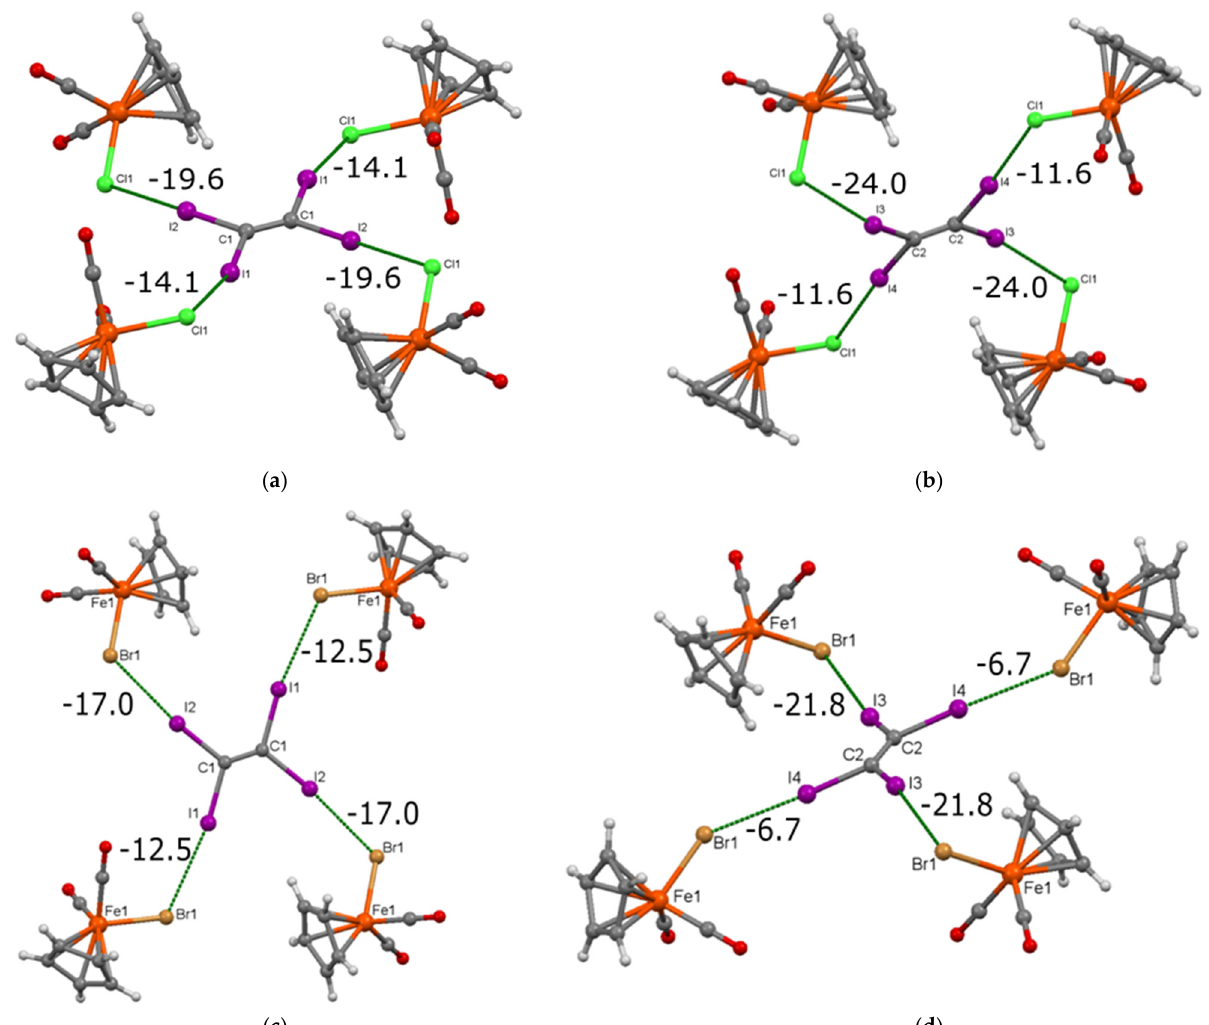
Figure 2. Fragments of the crystal structure of 1 , showing the supramolecular arrangement and intermolecular interaction energies around two independent C 2 I 4 molecules in 1 ( a , b ) and in 2 ( c , d ). Energy values are indicated in kJ/mol. Note that these are the total intermolecular interaction energies of the given molecular pairs, but not specific I ⋯ X HaB energies.